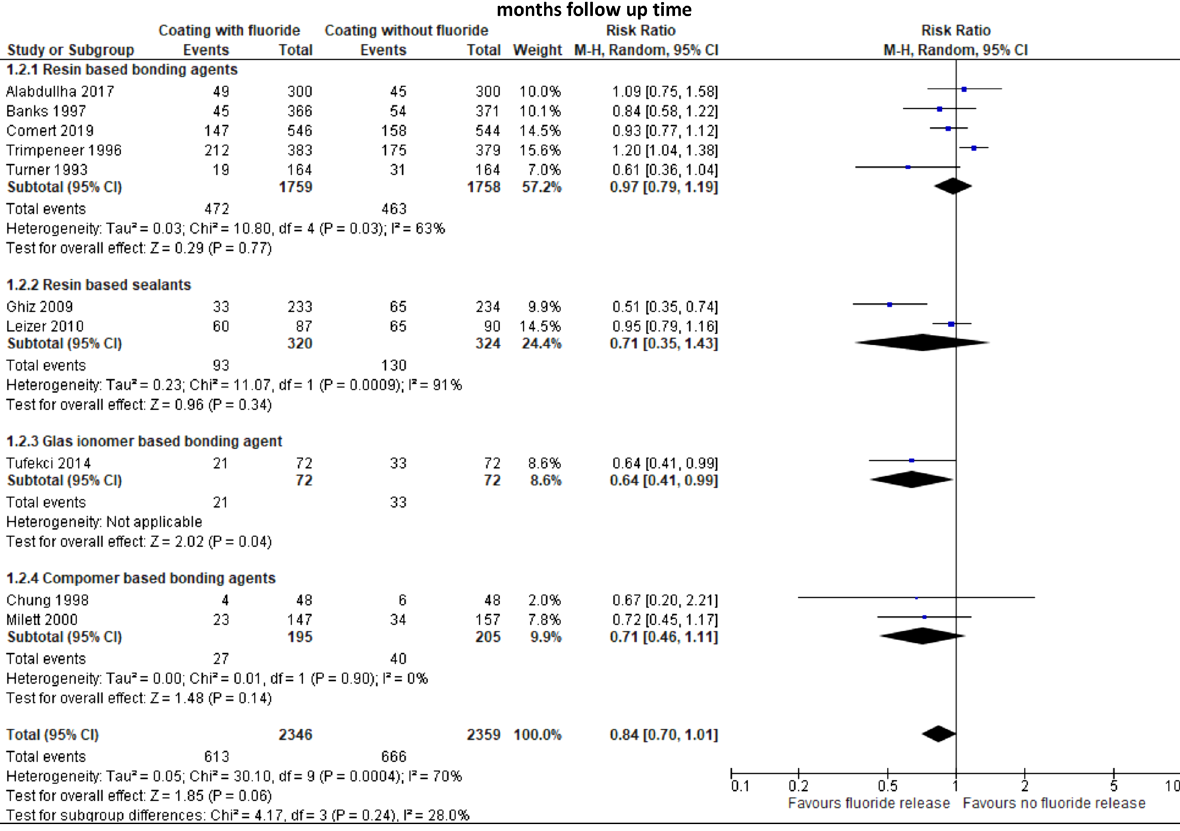
Figure 4. Meta-analysis for the comparison: coating with and without fluoride release. Visual-tactile assessments were used to calculate RR and 95%CI.